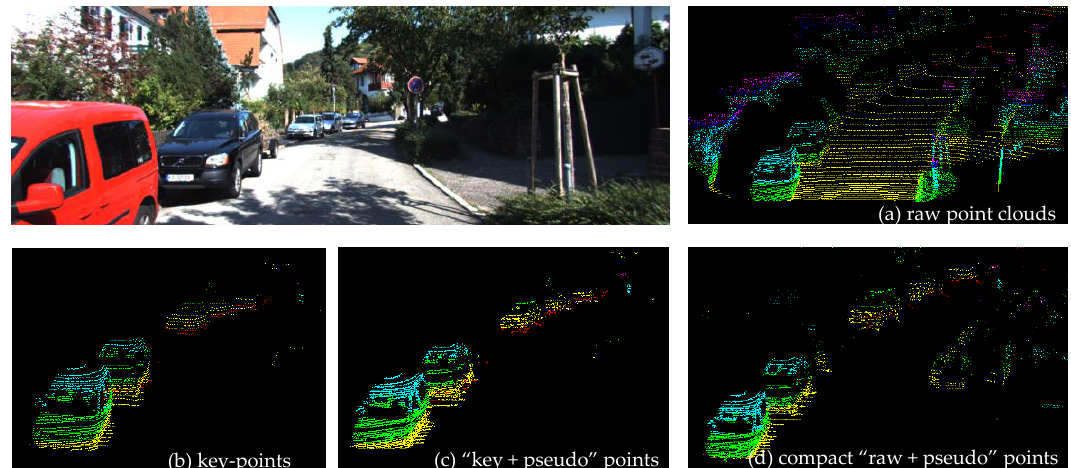
Figure 9. Visualizations of the results of key-point densification. ( a ) is a representative view of raw